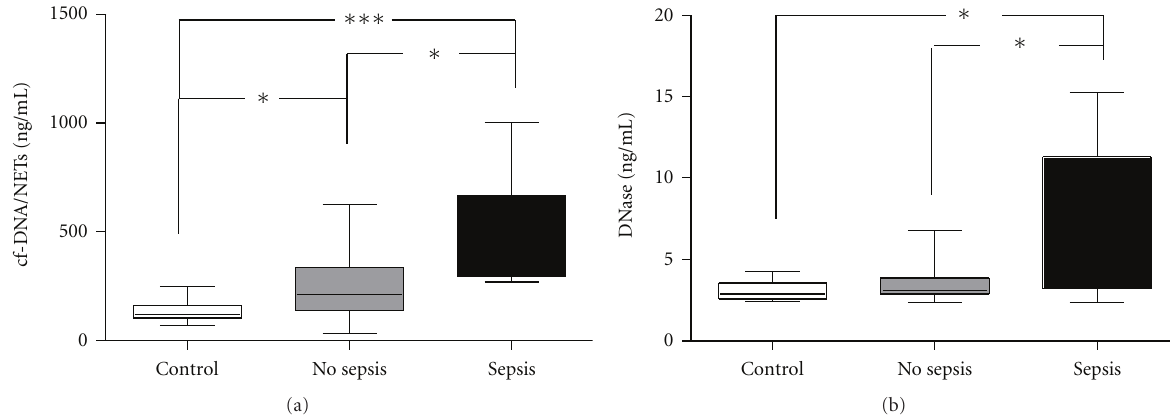
Figure 3: Values of cfDNA/NETs and DNase in the early septic phase. Highest values of cf-DNA/NETs and DNase in the range between the day before ( − 1), the day of (0), and the day after (+1) diagnosis of sepsis after major trauma. (a) cf-DNA/NETs values of patients with sepsis were significantly enhanced compared to patients with uneventful recovery ( P < 0 . 05) or healthy volunteers ( P < 0 . 0001). (b) Likewise values of DNase of patients who developed sepsis after major trauma were significantly enhanced compared to patients with uneventful recovery ( P < 0 . 05) or healthy volunteers ( P < 0 . 05). The horizontal line across the boxplots represents the median, and the lower and upper ends of the boxplots are the 25th and 75th percentiles, respectively. Whiskers indicate the minimum and maximum values, respectively. ∗ P < 0 . 05 and ∗∗∗ P < 0 .